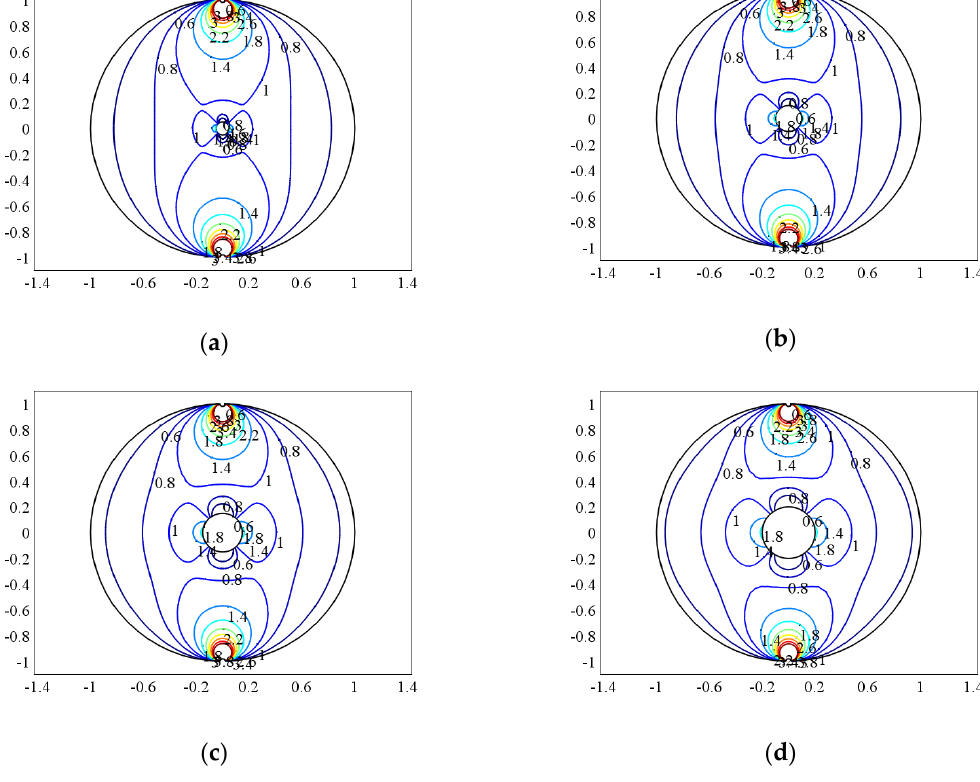
Figure 4. The weight function distribution when the bubble is concentric with the center of the pipe.